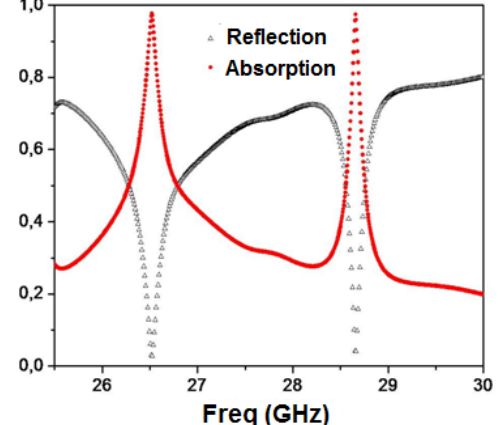
Figure 2: The reflection and absorption of two-layer absorber structure.